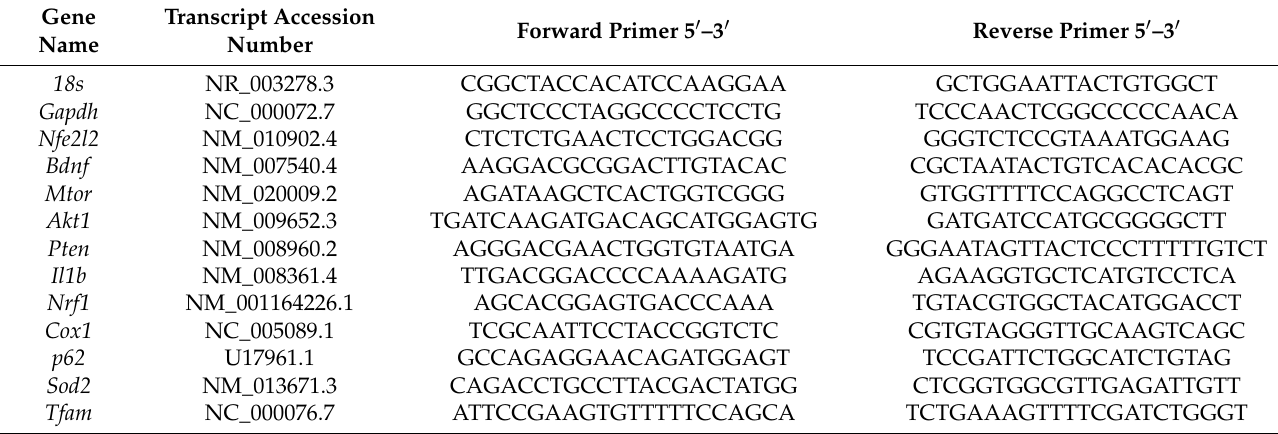
Table 4. Primer sequences for gene expression assessment.